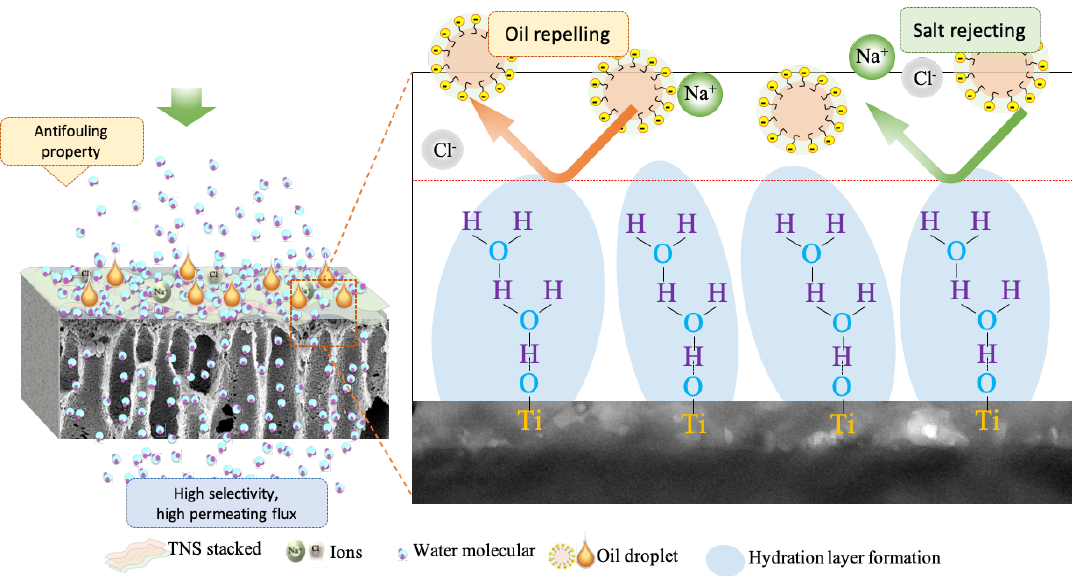
Figure 7. An explanatory sketch of oil repellent and salt rejection.